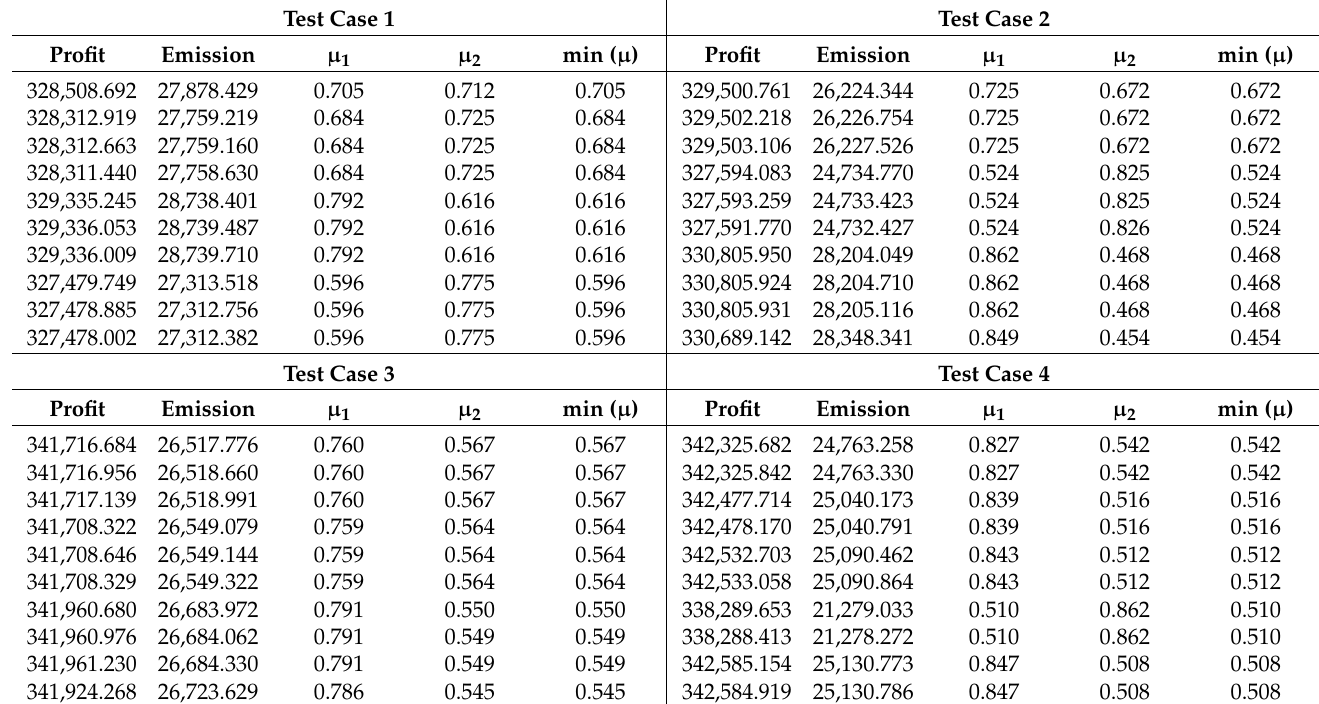
Table 5. Top 10 optimal solutions and their fuzzy min rank.